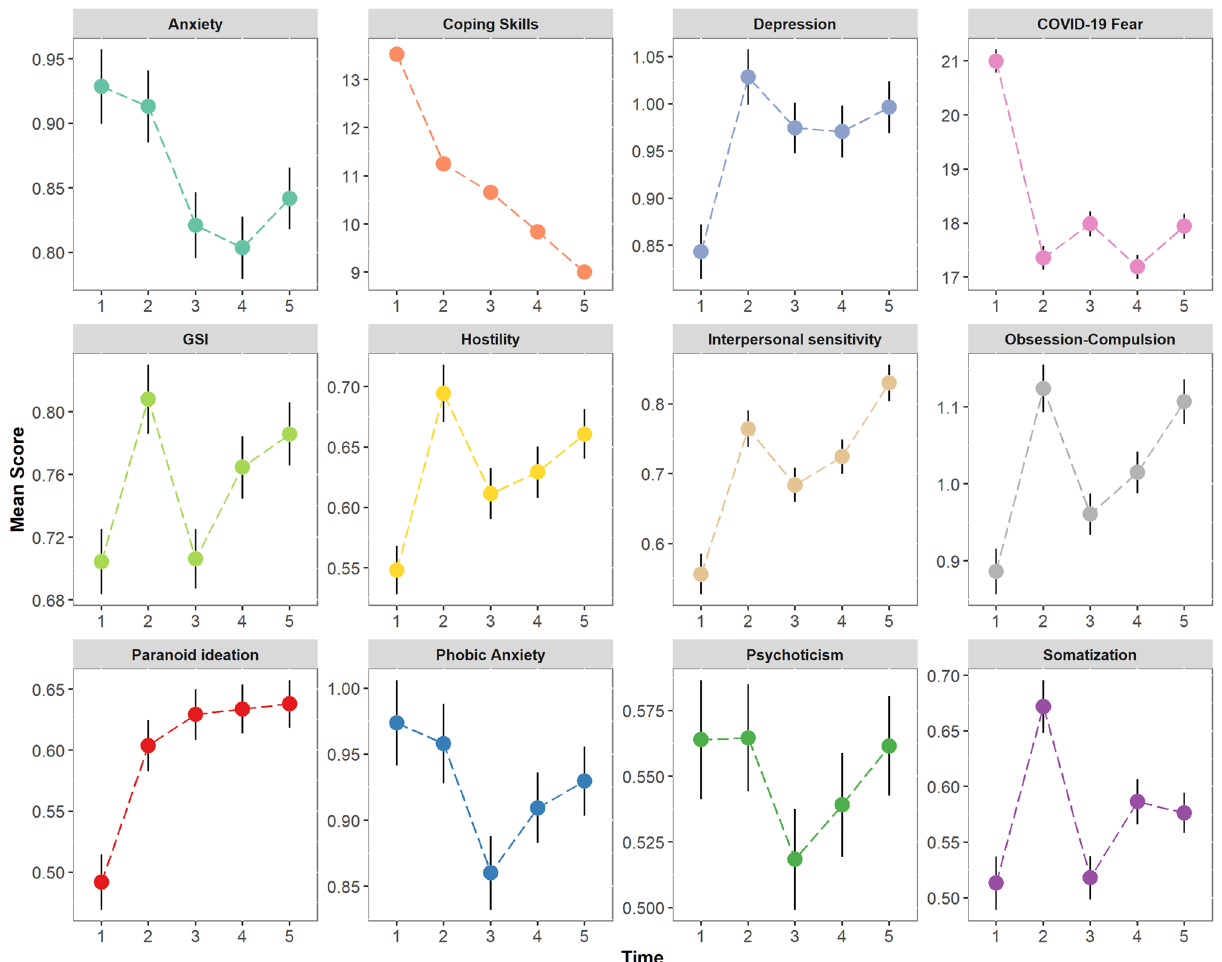
Figure 1. Overall mean scores of Psychological Distress (GSI), symptom dimensions of the BSI-53, and state- pandemic measures (COVID-19 related Fear and Coping skills during the pandemic scales) over Time (April 2020 to August 2021). Error bars represent standard